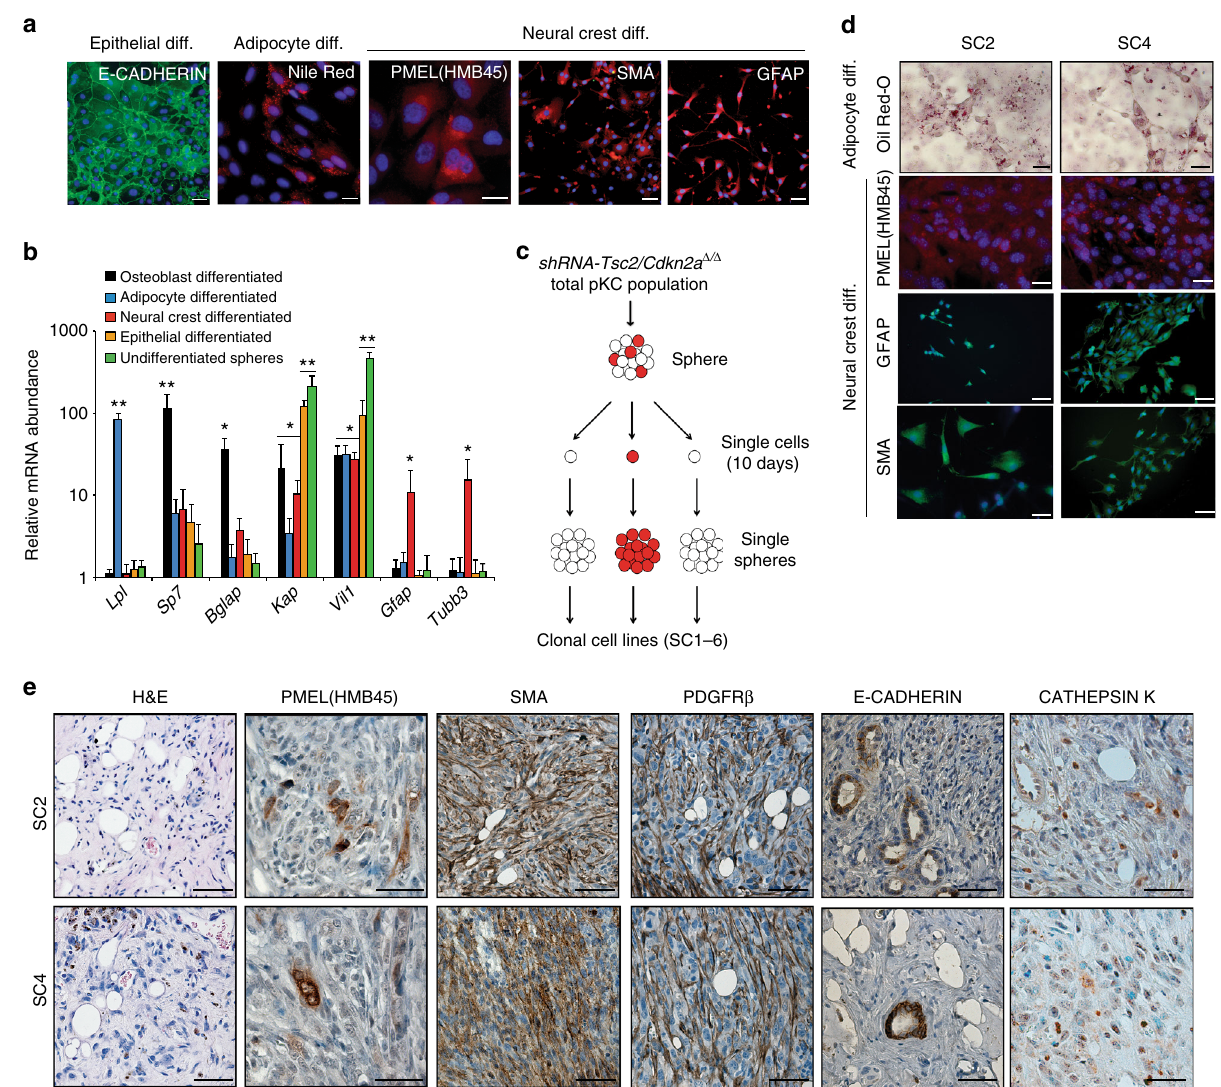
Fig. 2 Cells from Tsc2/Cdkn2a de fi cient spheres exhibit stem cell-like characteristics. a shRNA- Tsc2/Cdkn2a Δ / Δ spheres were cultured in speci fi c epithelial-, adipocyte- and neural crest-differentiation media and stained immuno fl uorescently using antibodies against E-CADHERIN, PMEL (HMB45), SMA or GFAP or stained with Nile Red. Scale bars: 50 μ m. b mRNA expression analysis of the indicated genes in sphere cells differentiated using the indicated conditions compared to undifferentiated spheres and normalised to expression levels in freshly isolated primary kidney cells. Graph depicts mean ± s.d. Student ’ s t test, n = 3. ∗ P < 0.05, ∗∗ P < 0.01. c Experimental overview of the generation of clonal cell lines (Sphere Clone 1 – 6 (SC1 – 6)). d Two independent sphere clones (SC2 and SC4) were cultured in speci fi c adipocyte- and neural crest-differentiation media and stained immuno fl uorescently using antibodies against PMEL (HMB45), GFAP or SMA or stained with Oil-Red-O. Scale bars: 50 μ m.Analyses of two additional sphere clones (SC3 and SC6) are shown in Supplementary Fig. 7a. e Representative pictures of AML-like allograft tumours obtained from SC2 and SC4. Positive immunohistochemical stainings of PMEL(HMB45), SMA, PDGFR β , E-CADHERIN and CATHEPSIN K. Scale bars: 50 μ m. Analyses of tumours from two additional sphere clones are shown